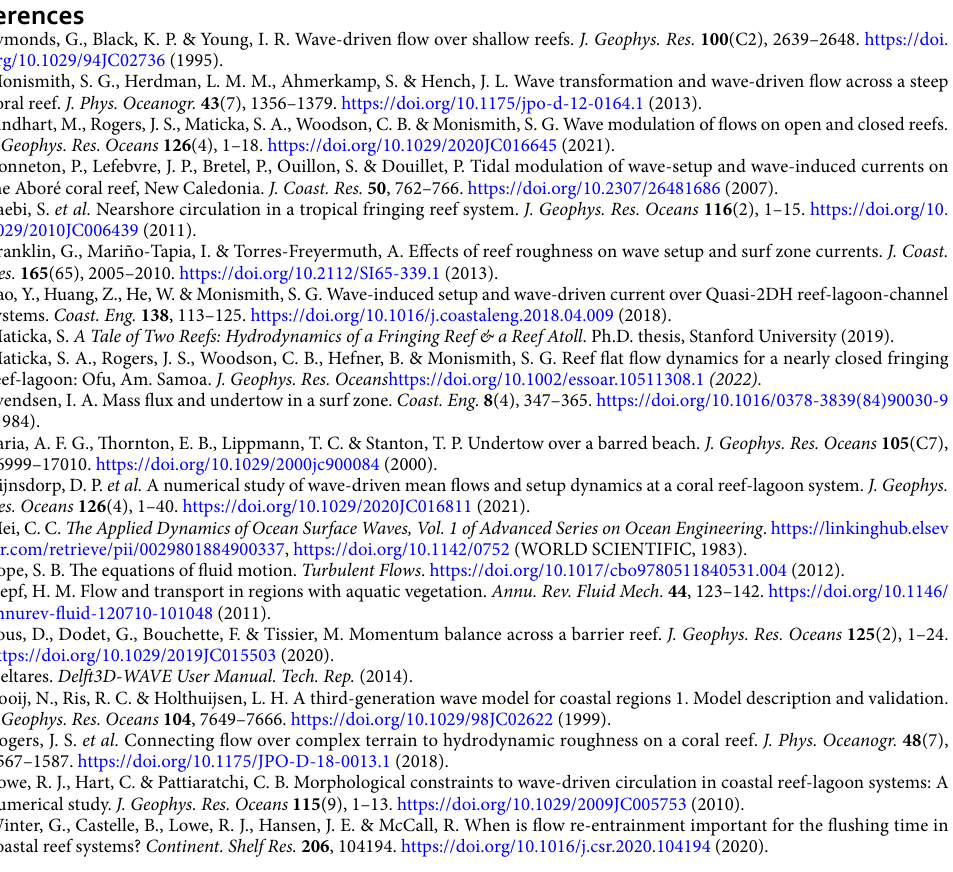
Figure 10. Mean residence time in hours on reef flat and in pools when initiated an hour before high tide. The superscripts R and B are used to differentiate between the drag coefficient on the reef flat, C B else C D